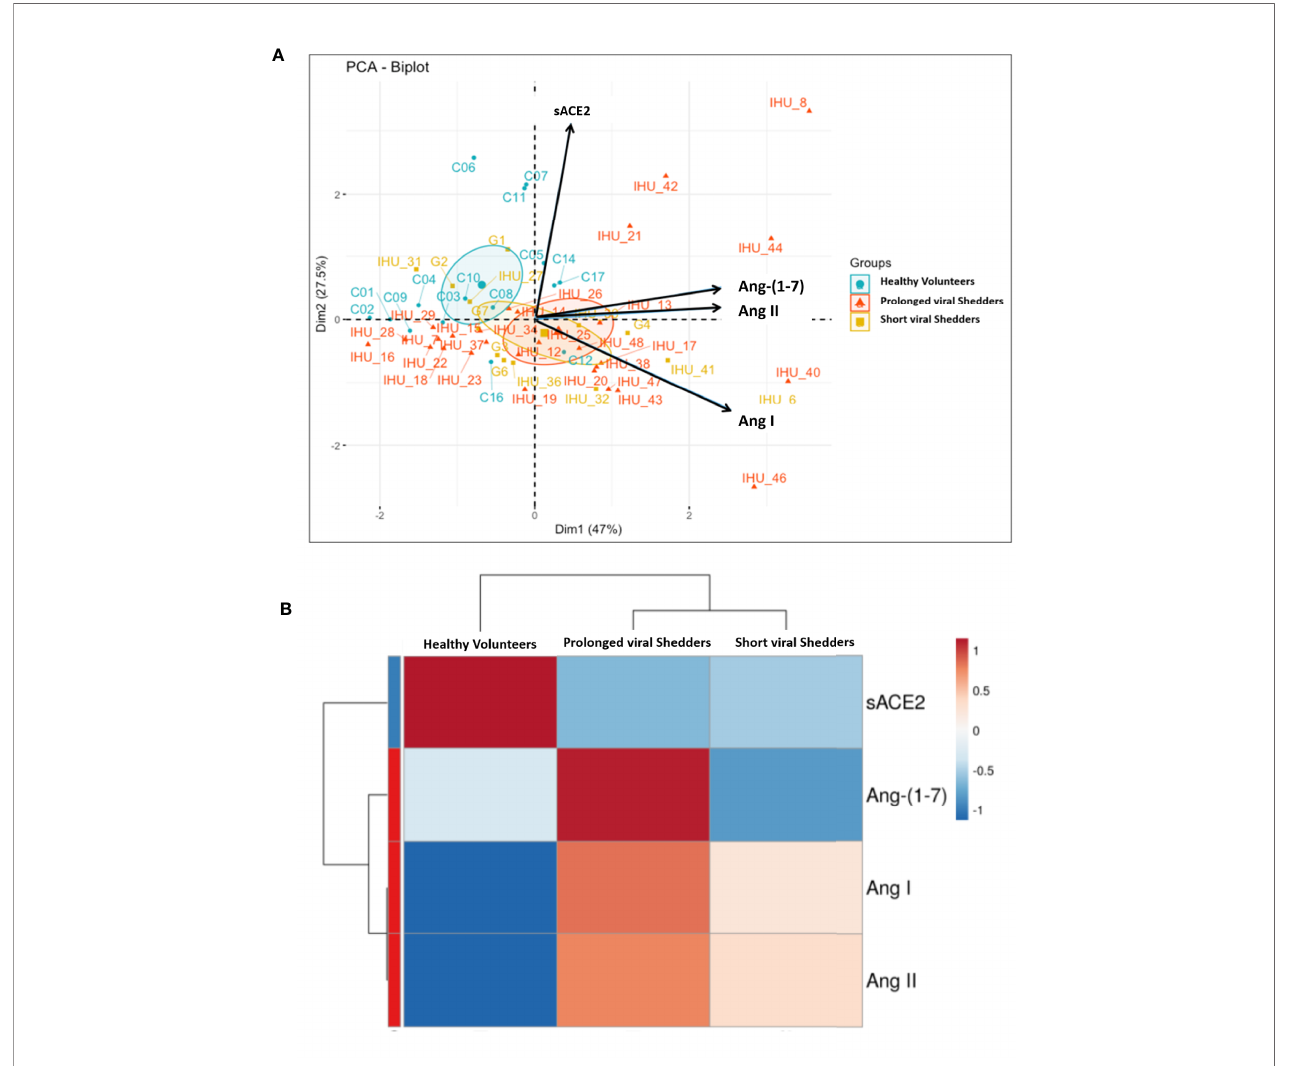
FIGURE 4 | (A) Representation of the principal component analysis (PCA) biplot (score plot + loading plot). All patient codes and clinical results were deidenti fi ed before being made available to the principal investigator (B) Hierarchical clustering heatmap analysis (each colored cell on the map corresponds to a concentration value) of the different angiotensin metabolites in